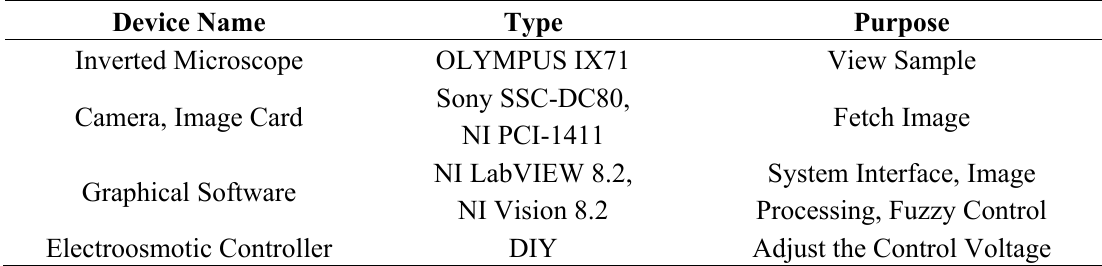
Table 2. Software and